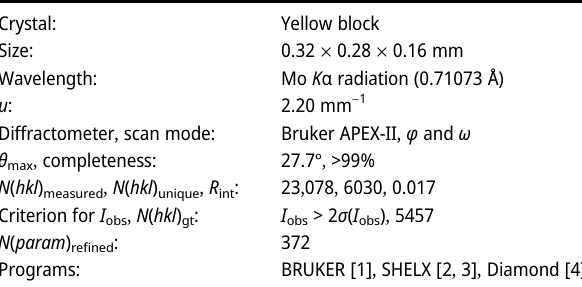
Table 1 contains crystallographic data and Table 2 contains the list of the atoms including atomic coordinates and displacement parameters.